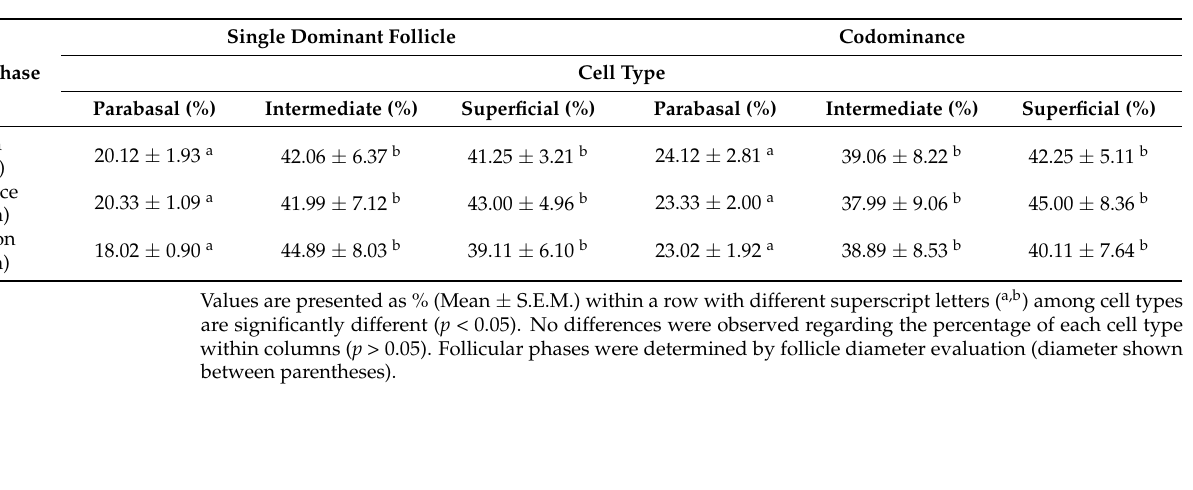
Table 4. Percentage of different cell types (parabasal, intermediate, and superficial) during follicular dynamics (single DF vs. codominance) obtained from vaginal cytological assessment in